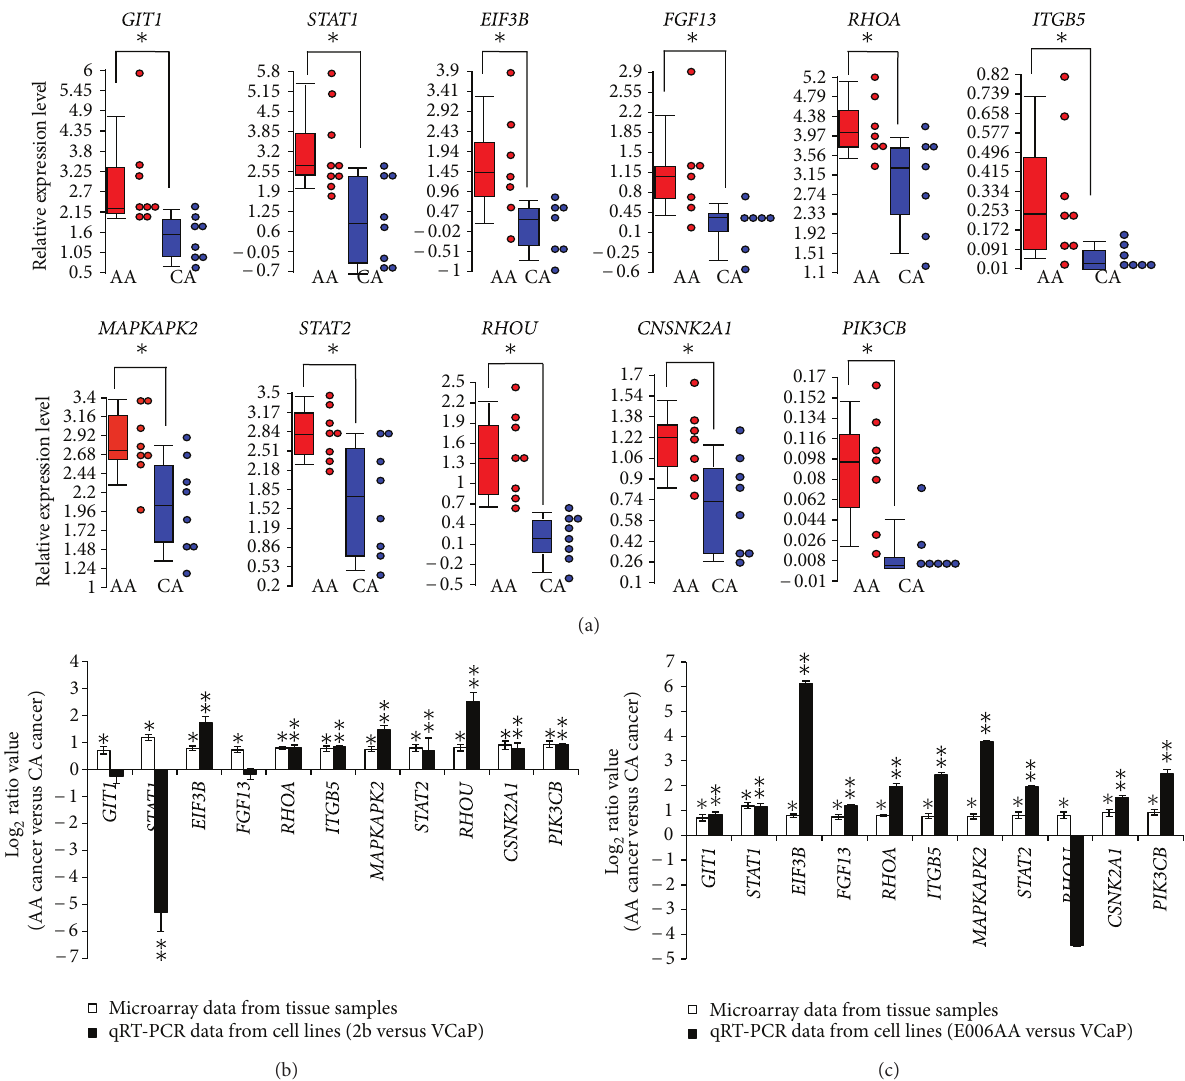
F 2: �uantitative RT-PCR validation of microarray results in patient specimens and population-speci�c PCa cell lines. qRT-PCR